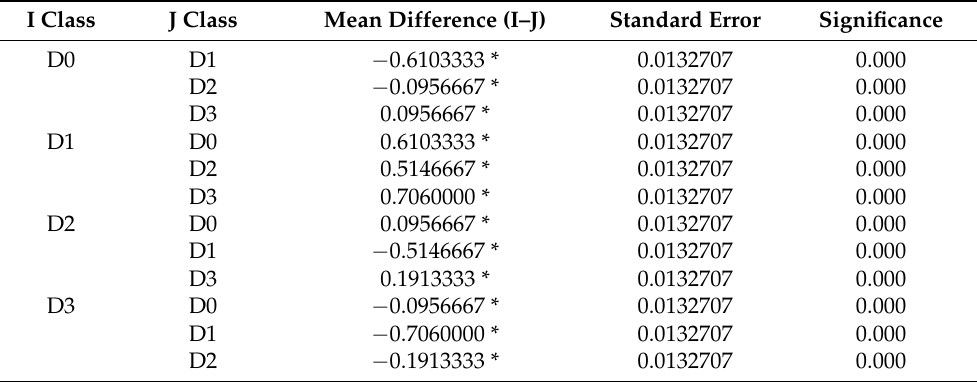
Table A8. Statistical Tukey’s HSD test for the nitrogen content of the leaves for the four excess nitrogen treatments: D0, D1, D2 and